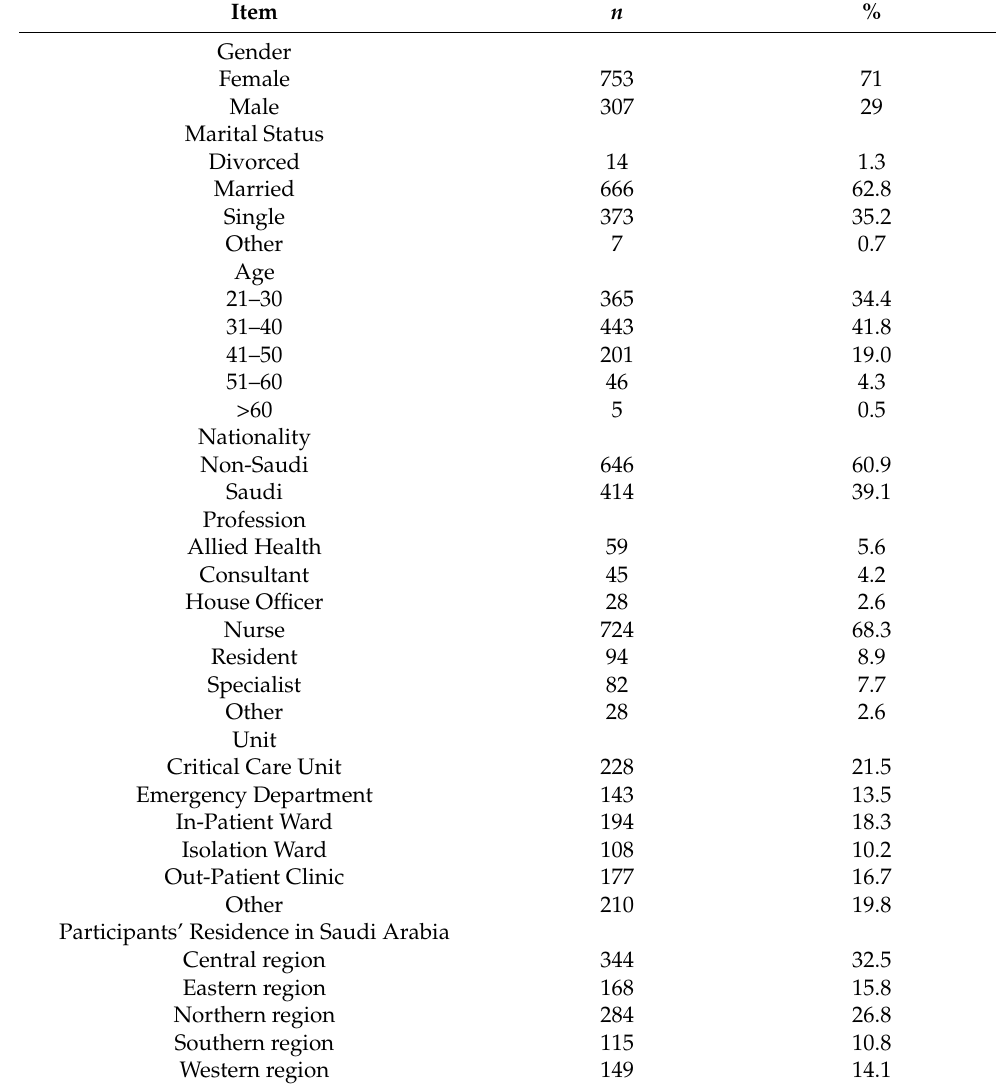
Table 1. Descriptive Statistics for Participants’ Demographic